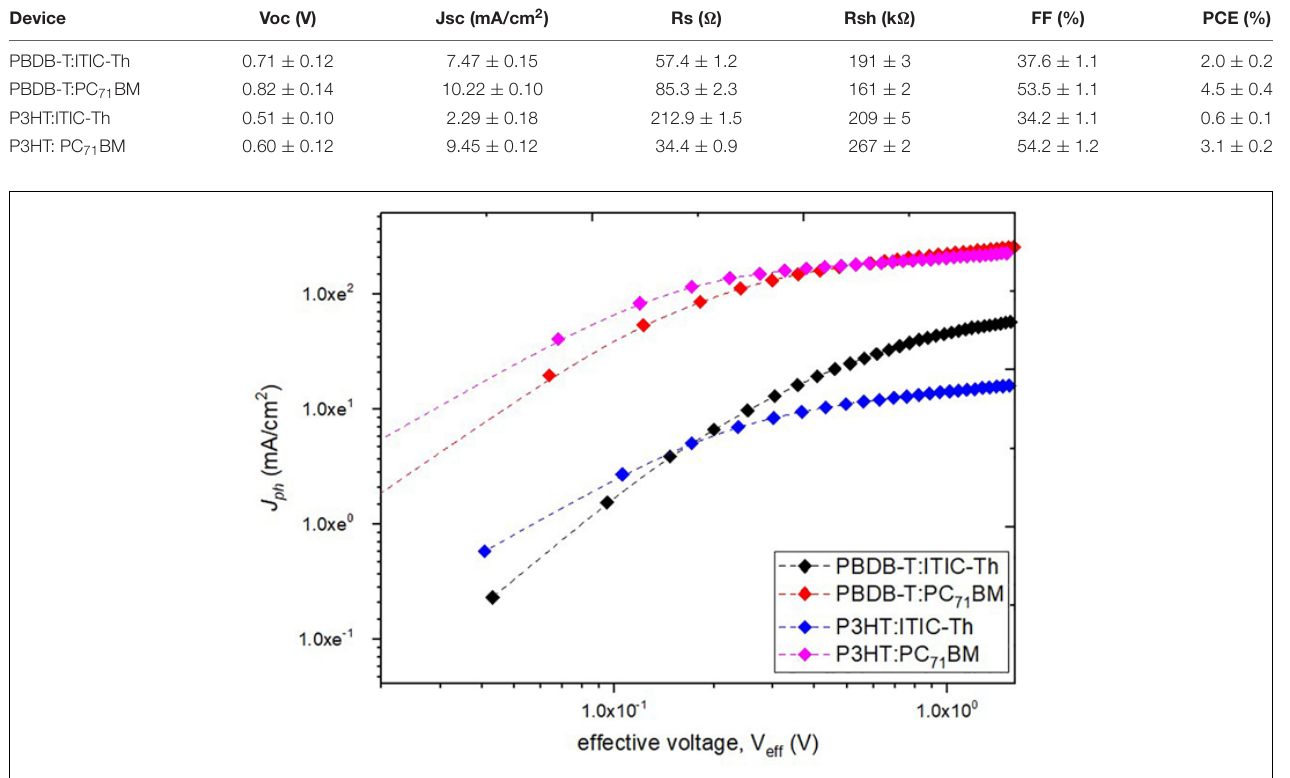
level orbitals of the polymers while Table 1 gives the extracted device